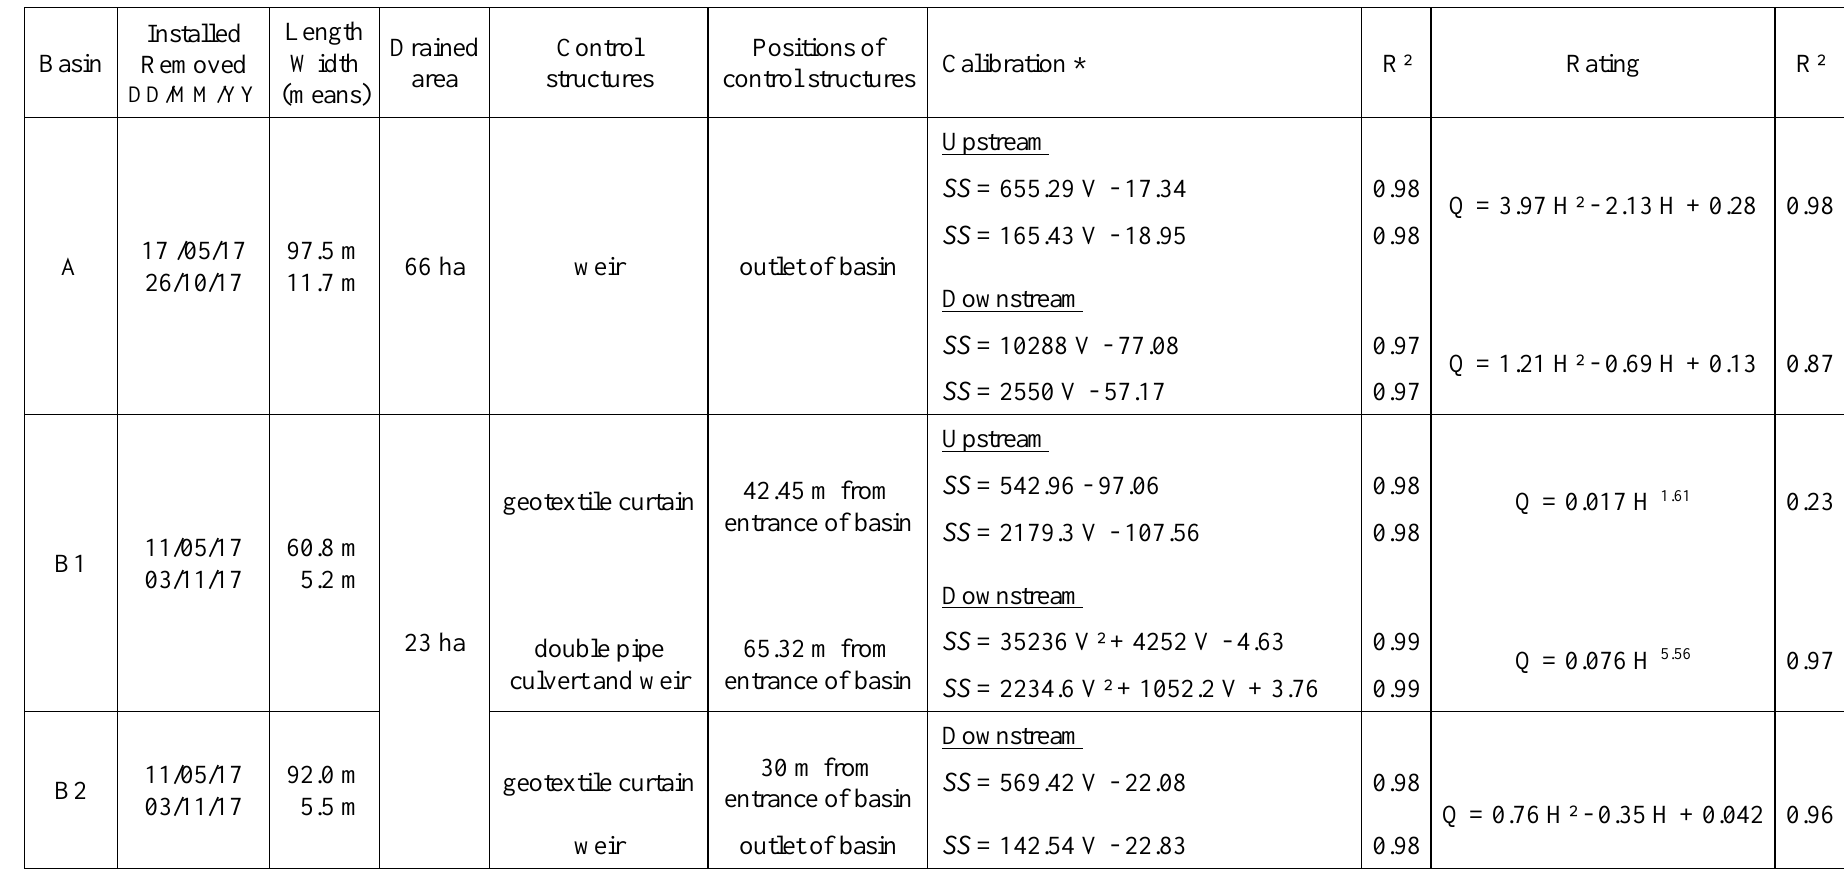
Table A1. For each studied basin: dates of the start and end of the recording period, length and width, drained areas, sediment / flow control structures and the position, calibration and rating equation used to calculate, respectively, suspended sediment concentration ( SS ; mg L -1 ) and flow (Q; m 3 s -1 ). V: turbidimeter signal (volt); H: water level